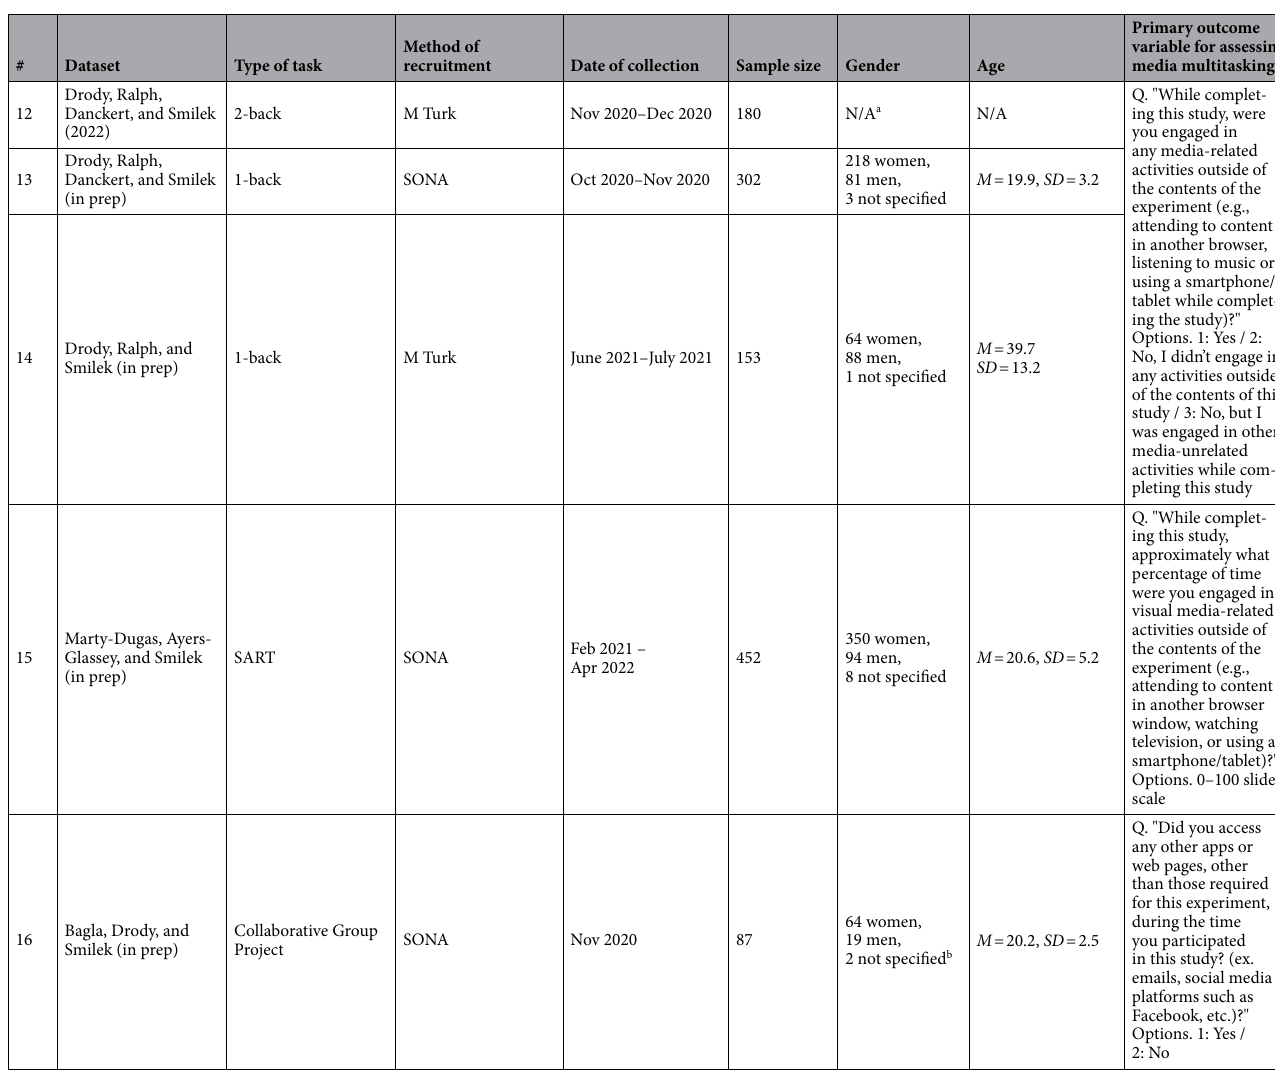
Table 1. Descriptions of online research studies examining media multitasking behaviours. a Demographic data was not collected. b Demographic data was not provided by all participants. Therefore, demographic statistics for this study are based on the 85 participants who did respond to the demographic